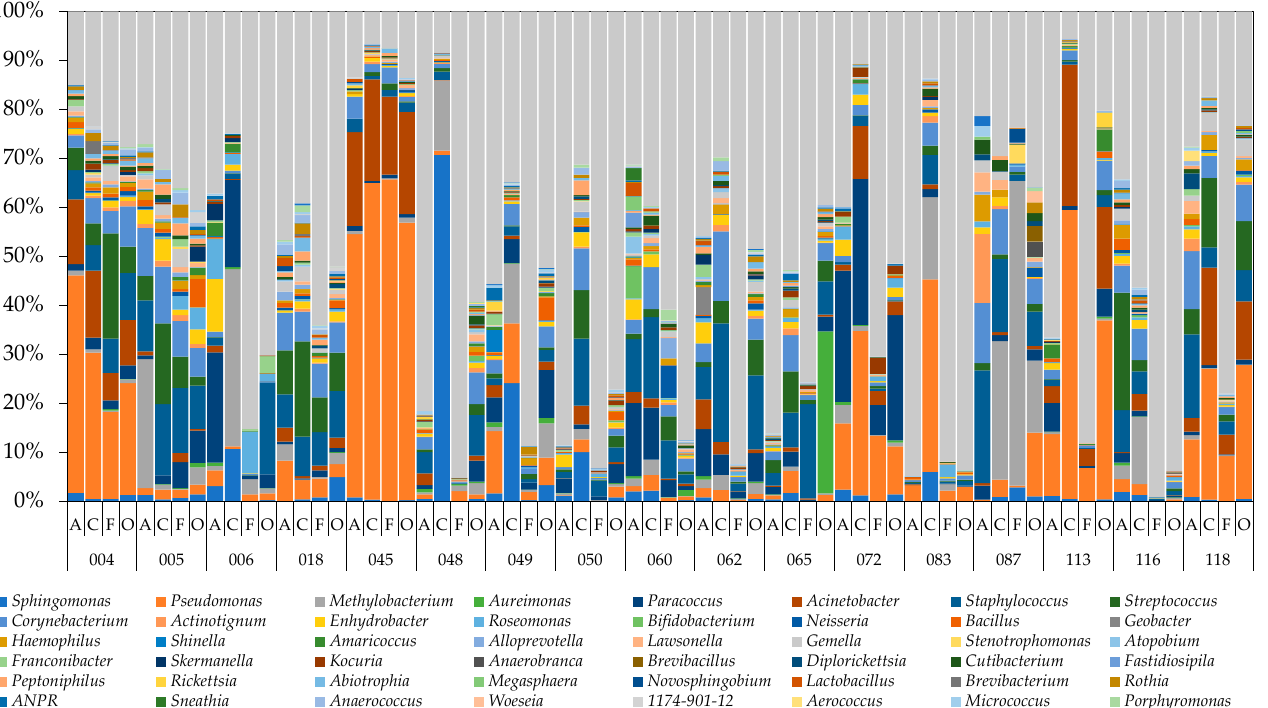
Figure 4. Relative abundance of 2% or higher of bacterial genera for all samples from the 17 houses. A, C, F, and O corresponded to air filter, cooling coil, fan, and air outlet. Genus ANPR : Allorhizobium-Neorhizobium -Pararhizobium-Rhizobium